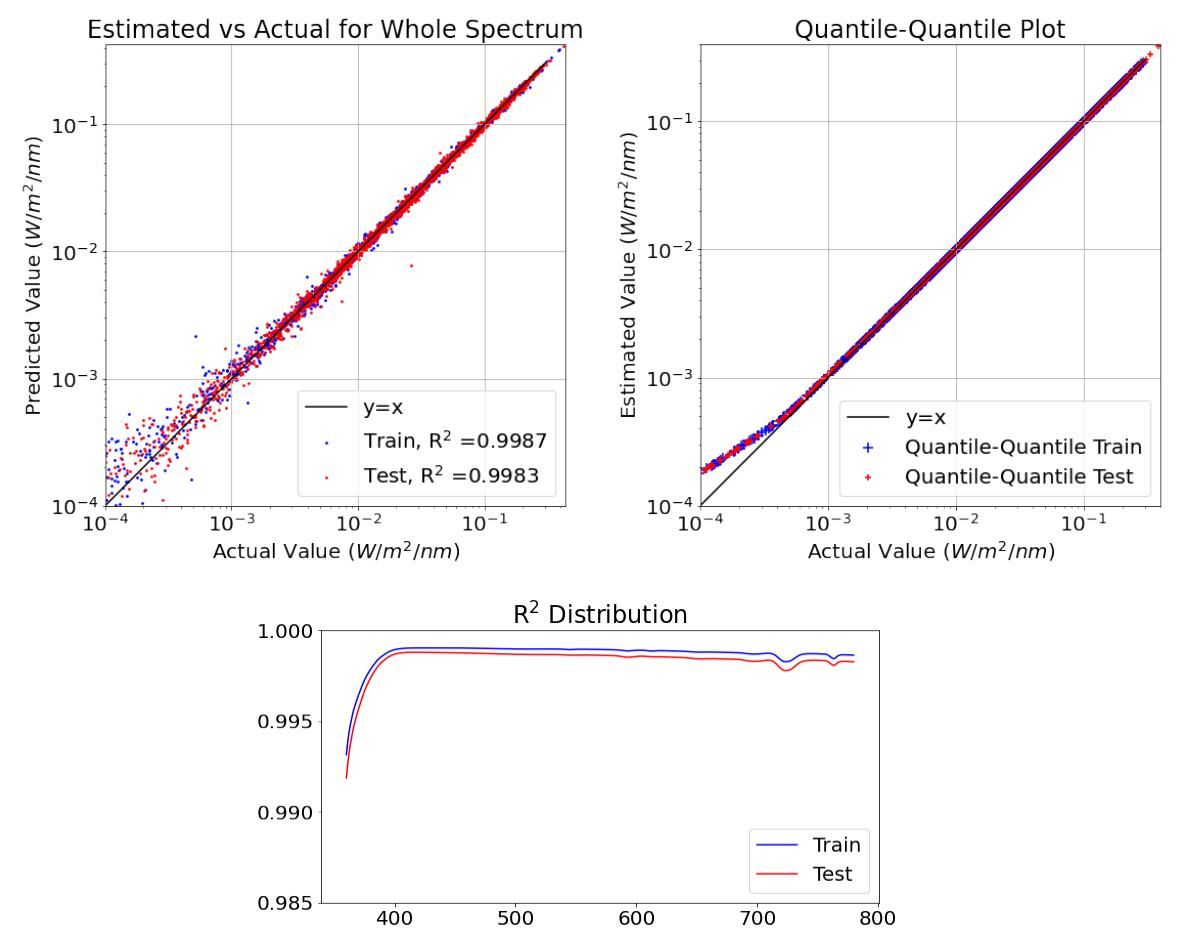
Figure 7. Whole spectrum model performance and the R2 scores on different